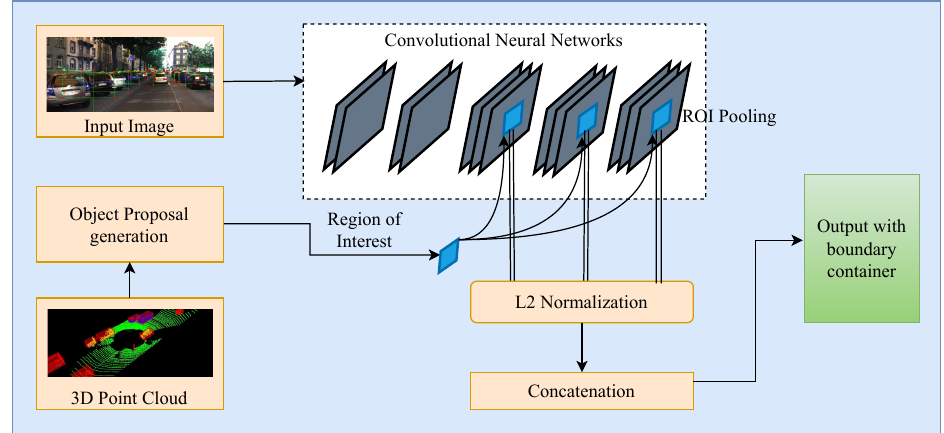
Figure 3. Workflow of the convolutional neural network architecture in the proposed OD-C3DL.